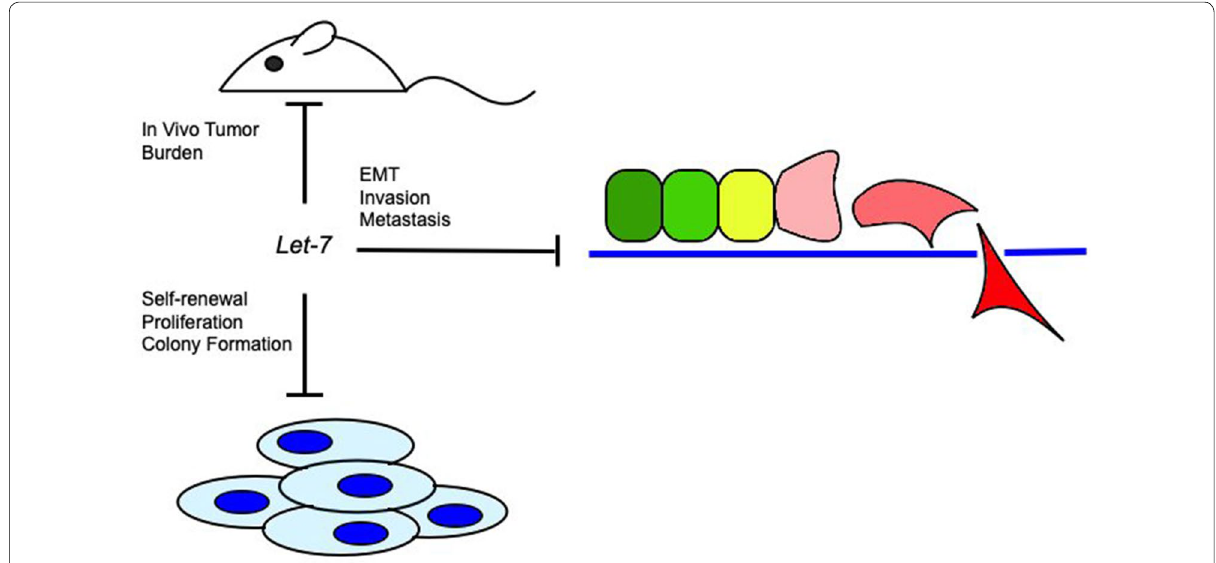
Fig. 2 Overview of tumor-suppresive let-7 effect on cancer functional